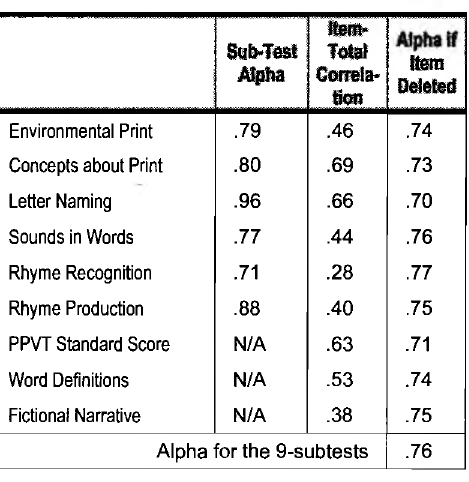
Table 3: Individual Cronbach’s Alpha, Item to Total Correlation and Effect on the Overall Cron­ bach’s Alpha Coefficient of Individual Sub-tests of